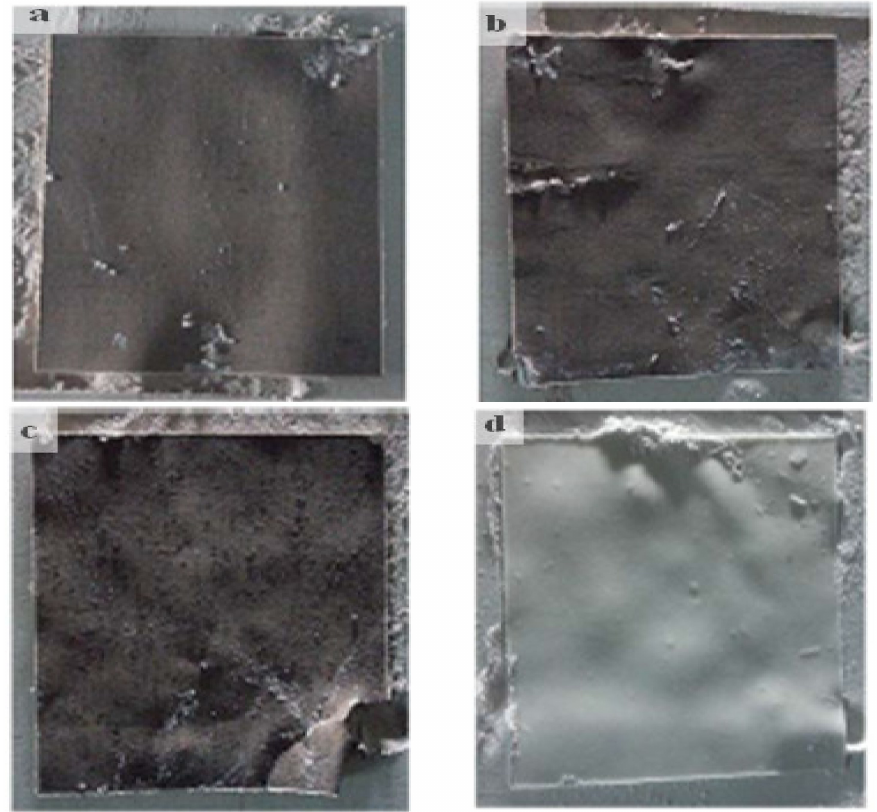
Figure 7. Single-layer sintered PCPC and PES samples prepared using di ff erent PCP and PES powder ratios, namely, ( a ) 10% PCP (10 / 90), ( b ) 15% PCP (15 / 85), ( c ) 20% PCP (20 / 80), and ( d ) pure PES.